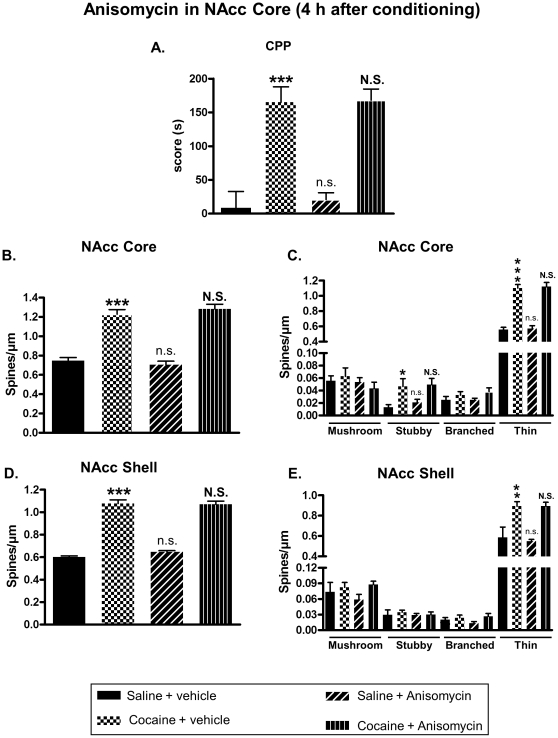
Anisomycin injection in the core 4 hours after cocaine conditioning has no effect on cocaine-induced CPP or neuroplasticity in the NAcc core and shell.CPP was induced in adult rats with saline or cocaine at 20 mg/kg. Four hours after each afternoon conditioning session, rats received intra-core infusion of anisomycin or vehicle. Just after the test, brains were processed for DeS analysis. CPP scores were expressed as the means ± S.E.M. (A) (Two-way ANOVA, Fcocaine(1,31) = 60.75, p<0.001; Fanisomycin(1,31) = 0.162 , p = 0.69; Fcocaine × anisomycin = 0.0548, p = 0.816). Total DeS density was expressed as spines/µm (mean ± S.E.M.) in MSN from the NAcc core (B) (Two-way ANOVA, Fcocaine(1,31) = 142.1, p<0.001; Fanisomycin(1,31) = 0.0197, p = 0.889; Fcocaine × anisomycin = 1.216, p = 0.278) and shell (D) (Two-way ANOVA, Fcocaine(1,31) = 327.7, p<0.001; Fanisomycin(1,31) = 0.6086, p = 0.441; Fcocaine × anisomycin = 1.117, p = 0.298). Density of mushroom, stubby, branched or thin spines was expressed as spines/µm (mean ± S.E.M.) in MSN from the NAcc core (C) (Two-way ANOVA mushroom, Fcocaine(1,32) = 0.0189, p = 0.891; Fanisomycin(1,31) = 1.2, p = 0.281; Fcocaine × anisomycin = 0.7711, p = 0.386; Two-way ANOVA stubby, Fcocaine(1,31) = 12.01, p<0.01; Fanisomycin(1,31) = 0.3576, p = 0.554; Fcocaine × anisomycin = 0.0765, p = 0.783; Two-way ANOVA branched, Fcocaine(1,31) = 4.099, p = 0.051; Fanisomycin(1,31) = 0.311, p = 0.58; Fcocaine × anisomycin = 0.311, p = 0.58; Two-way ANOVA thin, Fcocaine(1,31) = 154.3, p<0.001; Fanisomycin(1,31) = 0.126, p = 0.724; Fcocaine × anisomycin = 0.005, p = 0.938) and shell (E) (Two-way ANOVA mushroom, Fcocaine(1,32) = 2.102, p = 0.157; Fanisomycin(1,31) = 0.12, p = 0.731; Fcocaine × anisomycin = 0.564, p = 0.458; Two-way ANOVA stubby, Fcocaine(1,31) = 0.236, p = 0.63; Fanisomycin(1,31) = 0.167, p = 0.685; Fcocaine × anisomycin = 0.116, p = 0.735; Two-way ANOVA branched, Fcocaine(1,31) = 3.214, p = 0.082; Fanisomycin(1,31) = 0.188, p = 0.667; Fcocaine × anisomycin = 1.124, p = 0.297; Two-way ANOVA thin, Fcocaine(1,31) = 28.79, p<0.001; Fanisomycin(1,31) = 0.087, p = 0.769; Fcocaine × anisomycin = 0.101, p = 0.752). * p<0.05; ** p<0.01; *** p<0.001; n.s. (not significant) vs Saline + vehicle group; N.S. (not significant) vs Cocaine + vehicle group, Bonferroni post-hoc test, n = 7 to 10 animals/group.